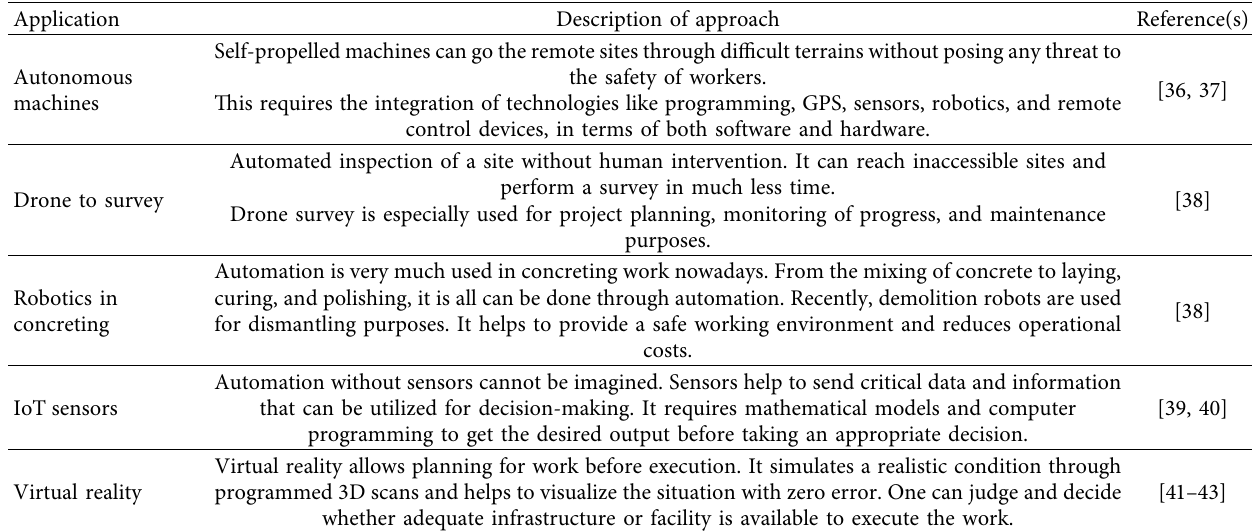
Table 1: A potential area of application of automation in the construction industry.